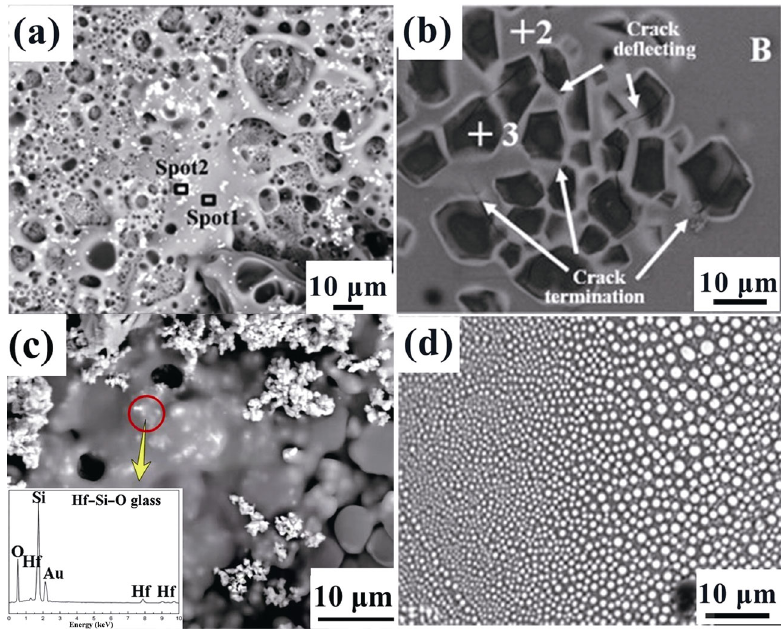
Fig. 37 Microstructures of glassy protective layers formed on the UHTC–silicide coatings: morphology and element analysis of Zr–Si–O glass [296] (a), Ta–Si–O glass [294] (b), Hf–Si–O glass [304] (c), and Hf–Ta–B–Si–O glass [320] (d). Reproduced with permission from Ref. [296], © Elsevier Ltd. 2018; Ref. [294], © Elsevier Ltd. 2014; Ref. [304], © Elsevier Ltd. 2018; Ref. [320], © Elsevier Ltd.